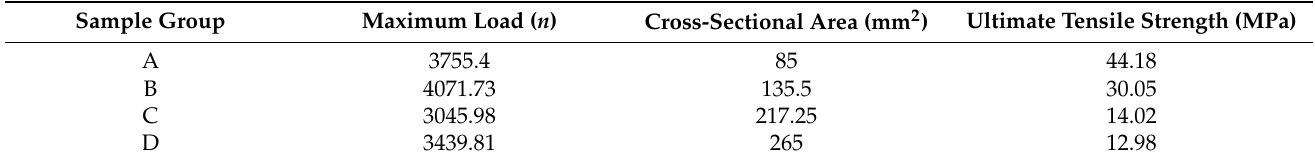
Table 7. Ultimate tensile strength of four groups of weft